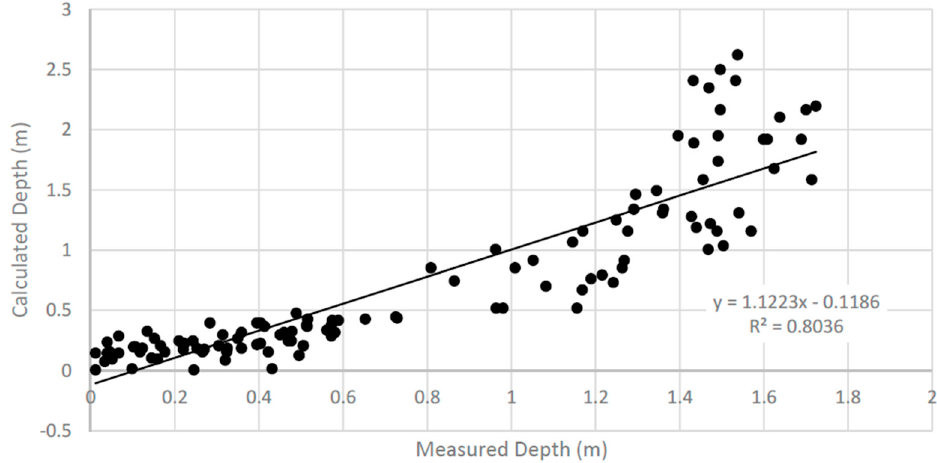
Figure 8. Measured versus calculated water depth (R 2 = 0.80).